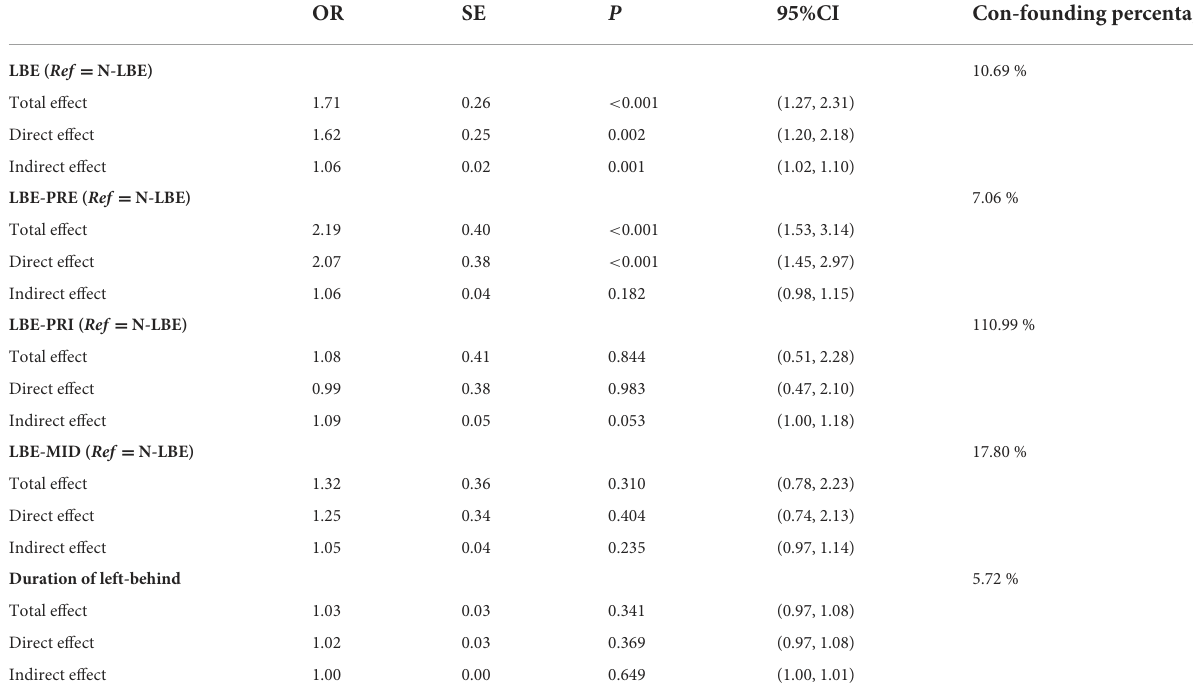
TABLE 5 Examining the indirect effect of social trust by using the KHB